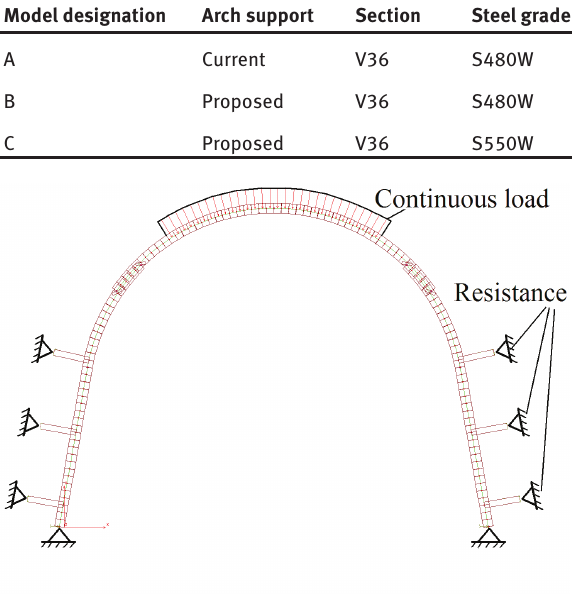
Figure 7: Variant III of the load on the